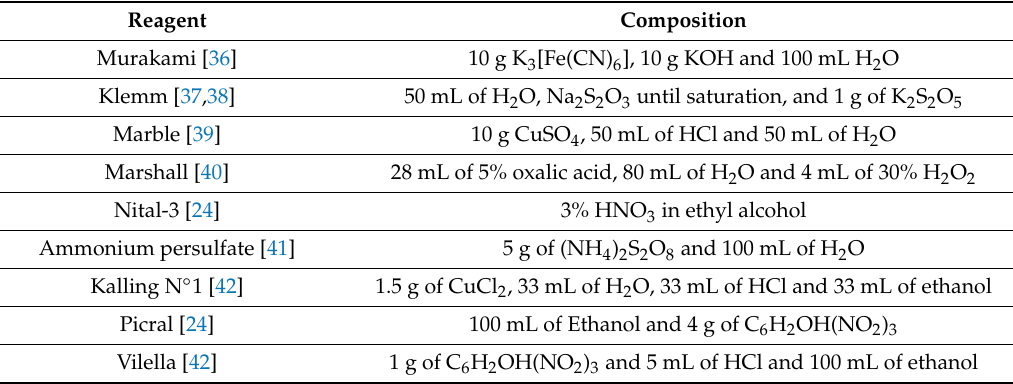
Table 1. Reagents